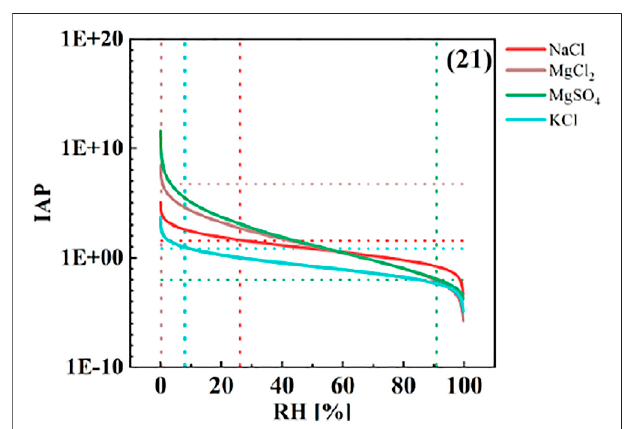
FIGURE 2 | IAP as a function of RH, including four salt components in sample #21. The horizontal dashed lines indicate the IAP sat of saturated solutionsoffourcommonsaltsmarkedonthe y -axis.Theverticaldashedlines point to the DRH simulated by the AIOMFAC model on the x